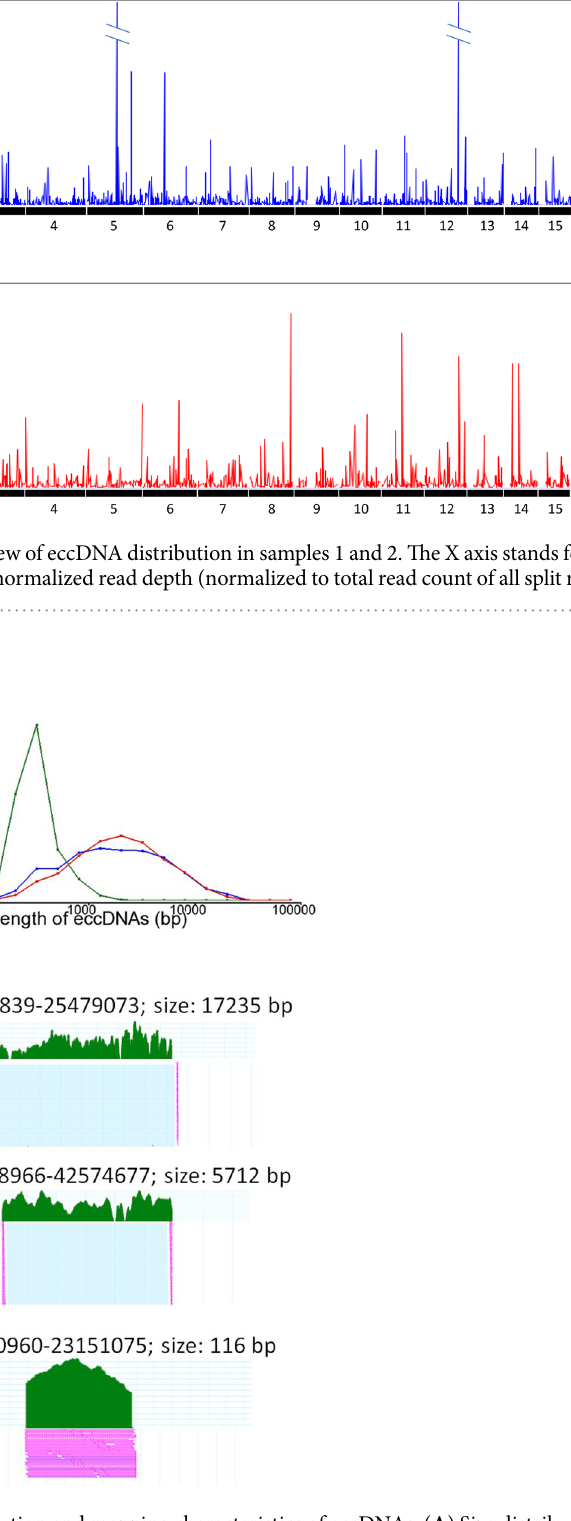
Figure 5. Size distribution and mapping characteristics of eccDNAs. ( A ) Size distribution of cell free eccDNAs in samples 1 (red line), 2 (blue line) and 4. For sample 1 and 2, the sizes of eccDNAs are from 31 bp to 19,989 bp (median 1801–1962 bp). The majority ( ≥ 80%) are smaller than 5000 bp. For sample 4, the majority ( > 89%) are less than 500 bp and the median size is 330 bp. ( B ) Representative mapped sequences in eccDNAs with large, medium and small sizes. From top to bottom, eccDNAs with 17,235 bp, 5,712 bp and 116 bp are shown along with the read depth and split reads (in